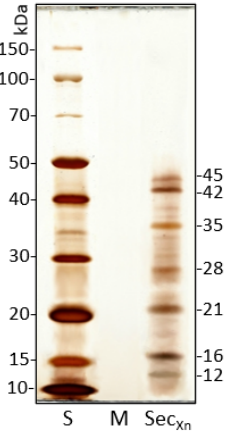
Figure 4. SDS-PAGE pattern of X. nematophila secretions shows 7 main bands, ranging from 10 to 45 kDa, and some less represented bands. The bacteria medium (M) has no detectable protein content.